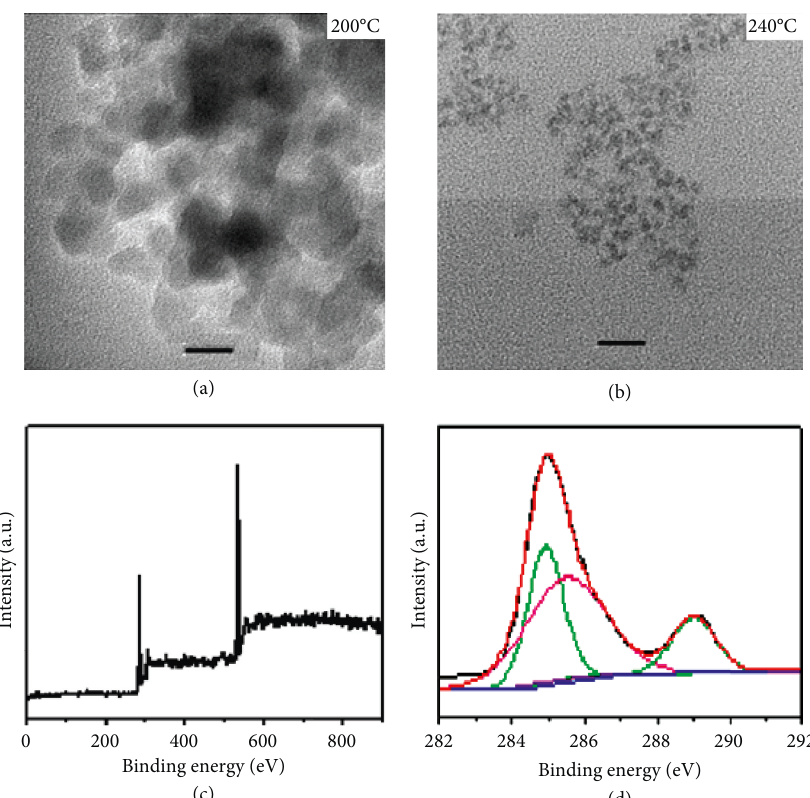
Figure 2: Characterizations of C-dots. (a, b) HRTEM image (the scale bar: 20 nm), (c) XPS spectrum, and (d) high-resolution XPS spectra of C1s of C-dots.